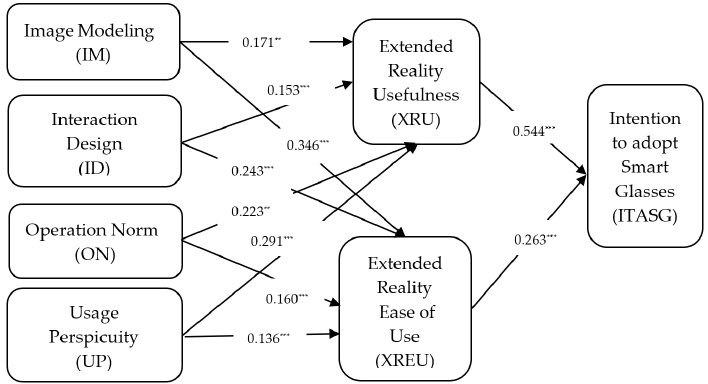
Figure 3. Result of hypotheses testing.